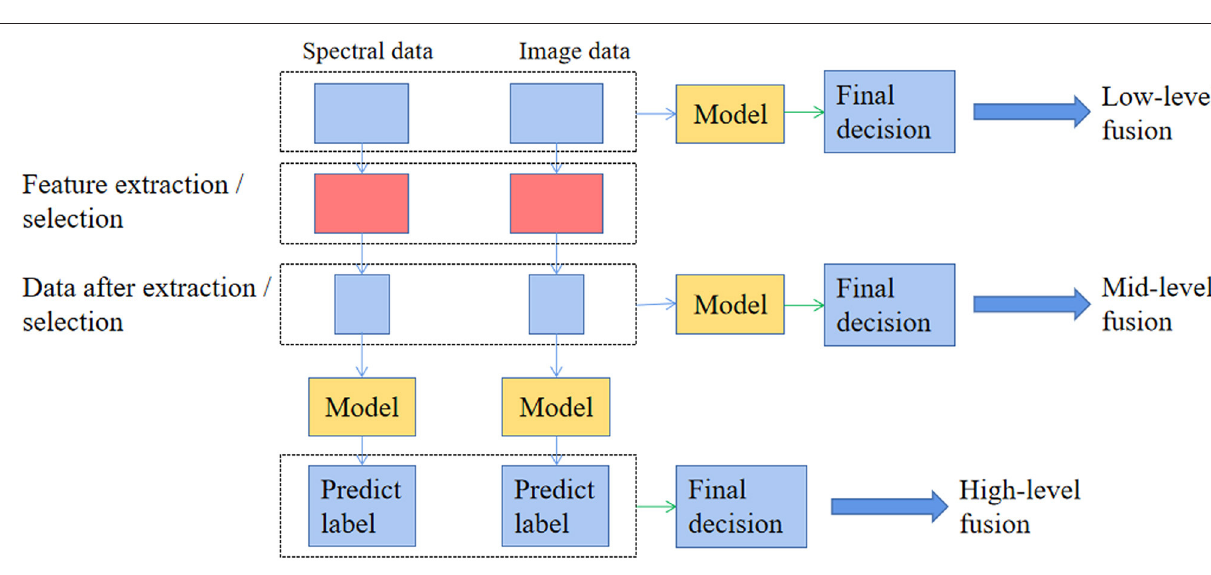
FIGURE 3 | The different types of data fusion with hyperspectral imaging for food varieties and geographical origins